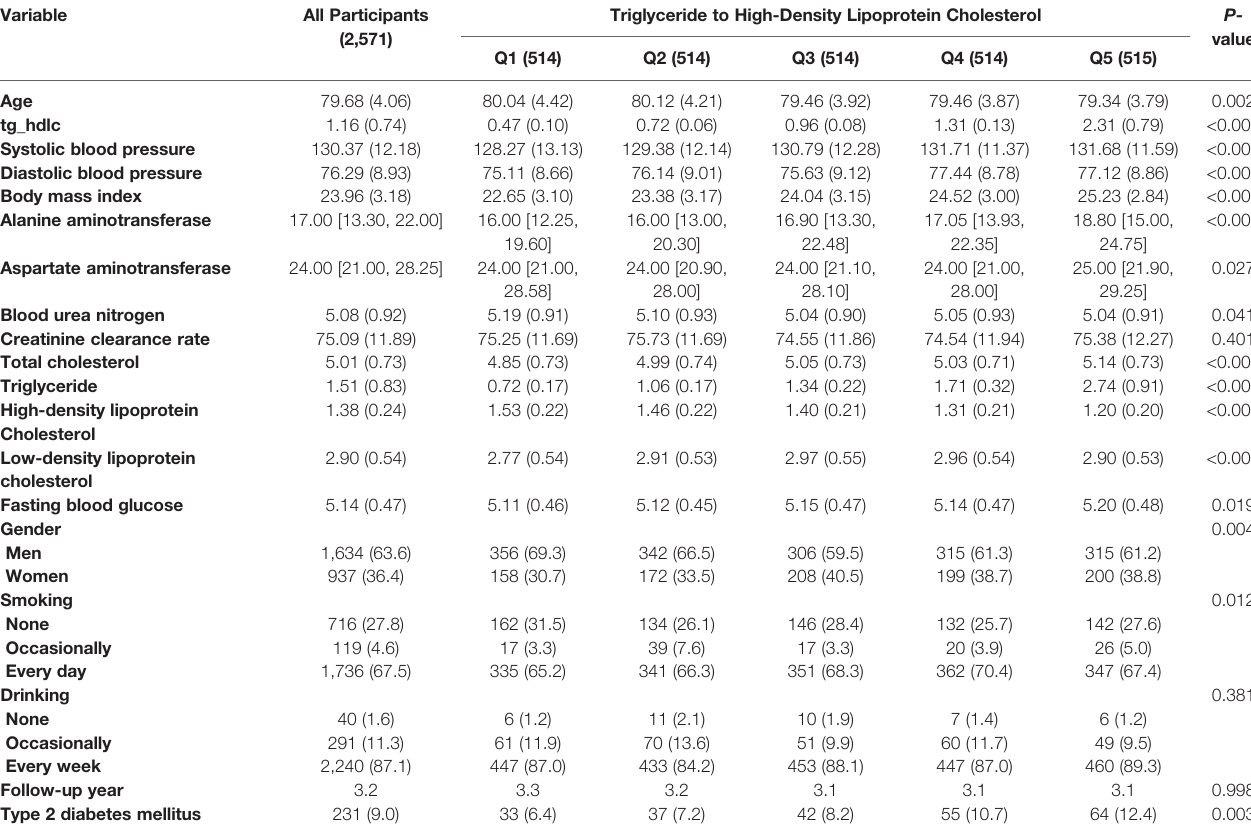
TABLE 1 | Baseline characteristics of the participants. Variable All Participants